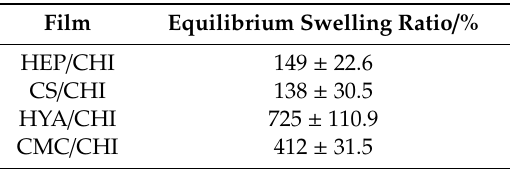
Table 3. Equilibrium swelling ratio of polysaccharide composite films.